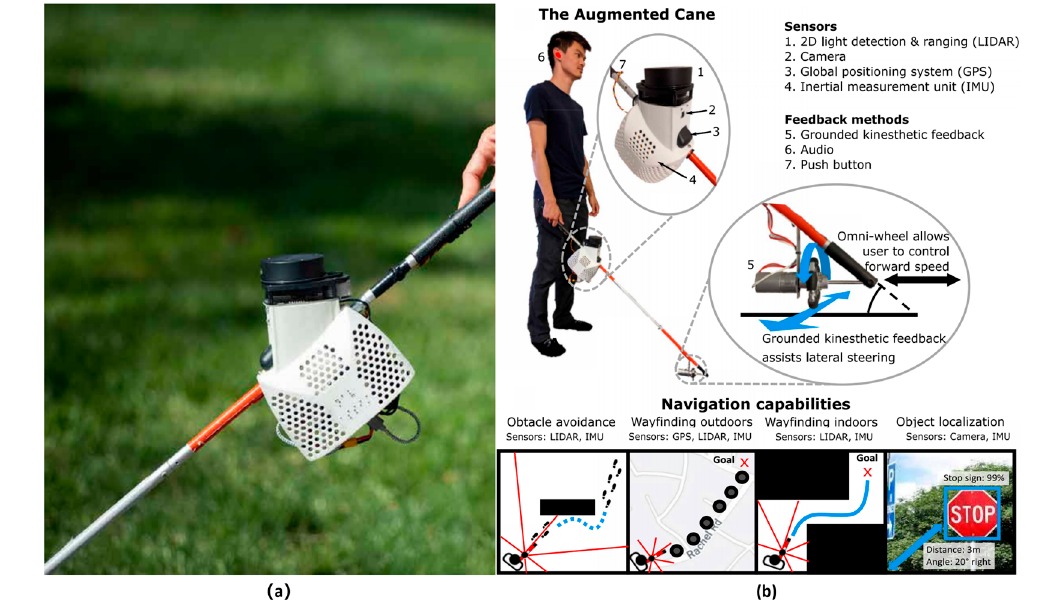
Figure 3. ( a ) Laser SLAM smart cane; ( b ) System diagram of the smart cane [21].